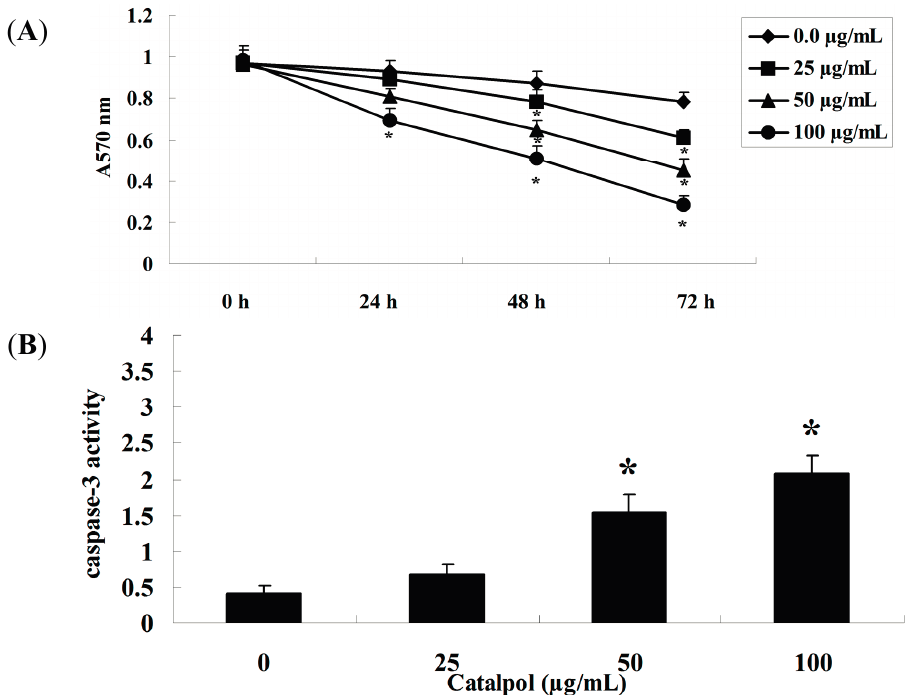
Figure 2. The effect of catalpol on OVCAR-3 cell growth. Catalpol treatment dose-dependently inhibited the viability of OVCAR-3 cells ( A ) and activity of caspase-3 was significantly enhanced after treatment ( B ). * p < 0.01 compared with 0 mg/mL catalpol treatment